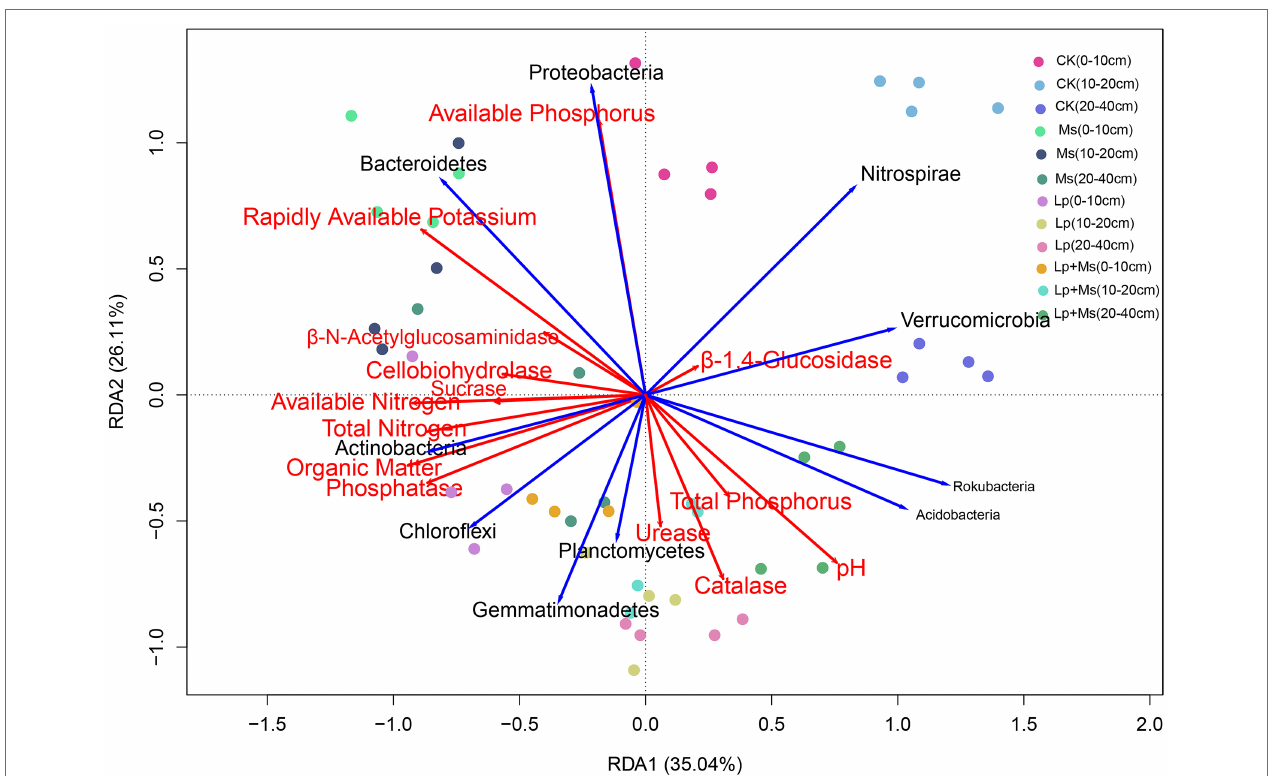
FIGURE 7 | Redundancy analysis between soil nutrients and dominant bacterial